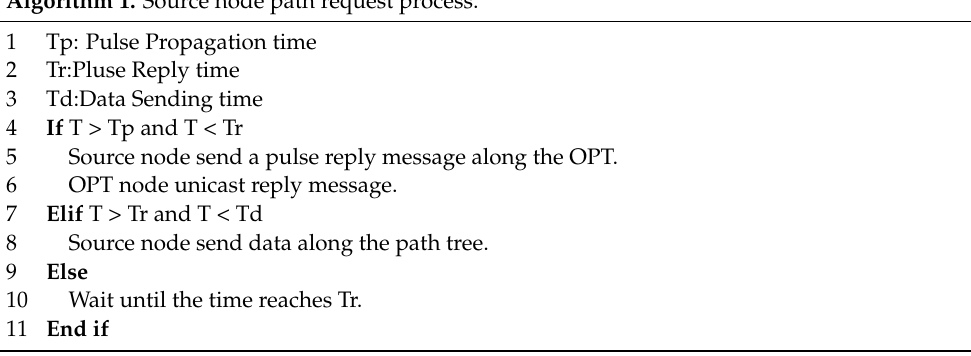
Figure 4. Schematic diagram of spanning tree.